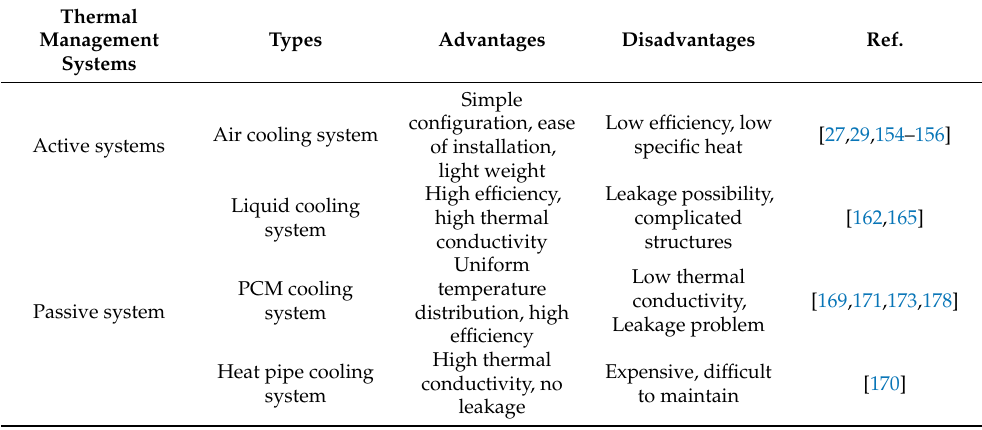
Table 5. Advantages and disadvantages of various thermal management